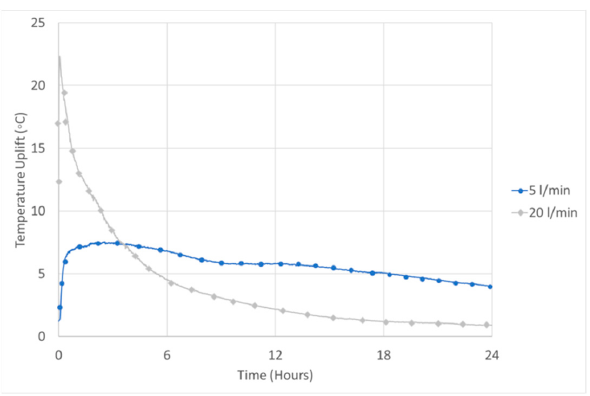
Figure 3. Long term performance of the 2:1 CaCl 2 : VM SIM for an input flow rate of 5 L/min and 20 L/min in reactor 1.